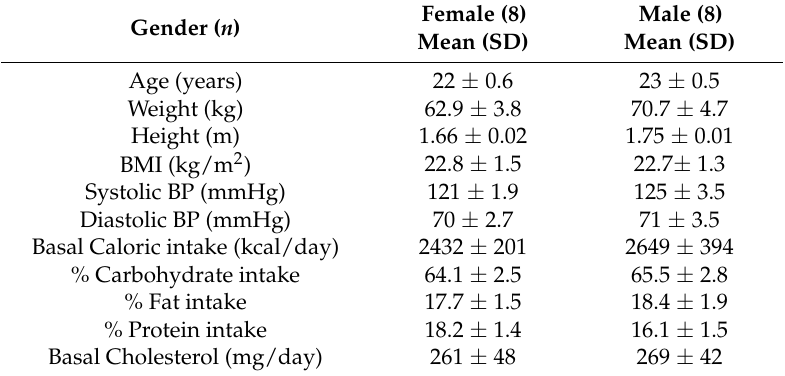
Table 1. Anthropometrical and physiological characteristics and average daily macronutrient intake of male and female volunteers. Values shown are means ± SD.